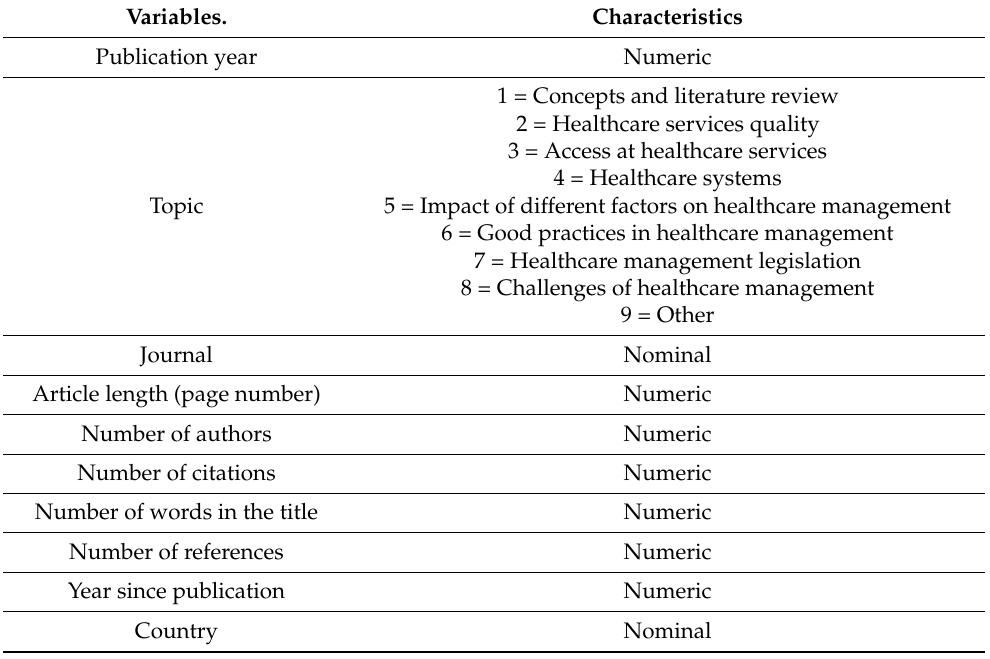
Table 2. Studied variables and their characteristics.